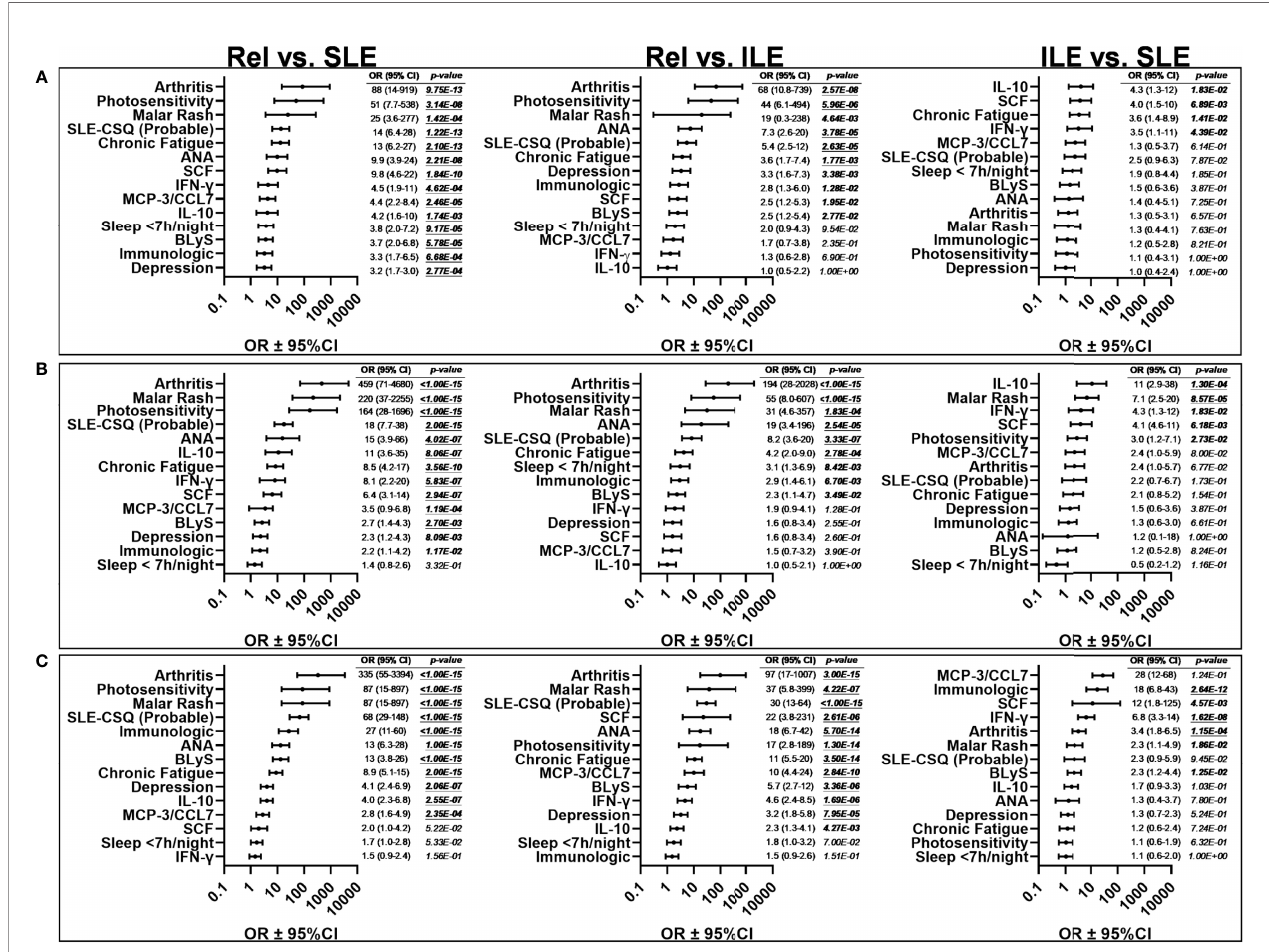
FIGURE 6 | Effect size of informative variables that distinguish lupus relatives prior to and after disease transition in the LAUREL and LFRR cohorts. Odds ratios (± 95% CI) were determined by Fisher exact test for lupus relatives (Rel) vs. relatives who transitioned to SLE, prior to SLE classi fi cation in the LAUREL baseline cohort (A , Rel vs. SLE ) , for clinical, serologic, and immunologic differentiating variables as outlined in Table S3 . Bonferroni ’ s correction for multiple comparison was applied to all signi fi cant variables ( p<0.05 ); the 14 variables with p ≤ 0.0036 were considered signi fi cant for differentiating Rel vs. SLE (A) prior to disease transition. These same variables were assessed for effect size and signi fi cance comparing Rel vs ILE and ILE vs SLE prior to disease transition in the LAUREL cohort at baseline (A) , as well as Rel vs SLE, Rel vs ILE, and ILE vs SLE after disease transition in the LAUREL cohort at follow-up (B) , as well as the LFRR con fi rmatory cohort (C)